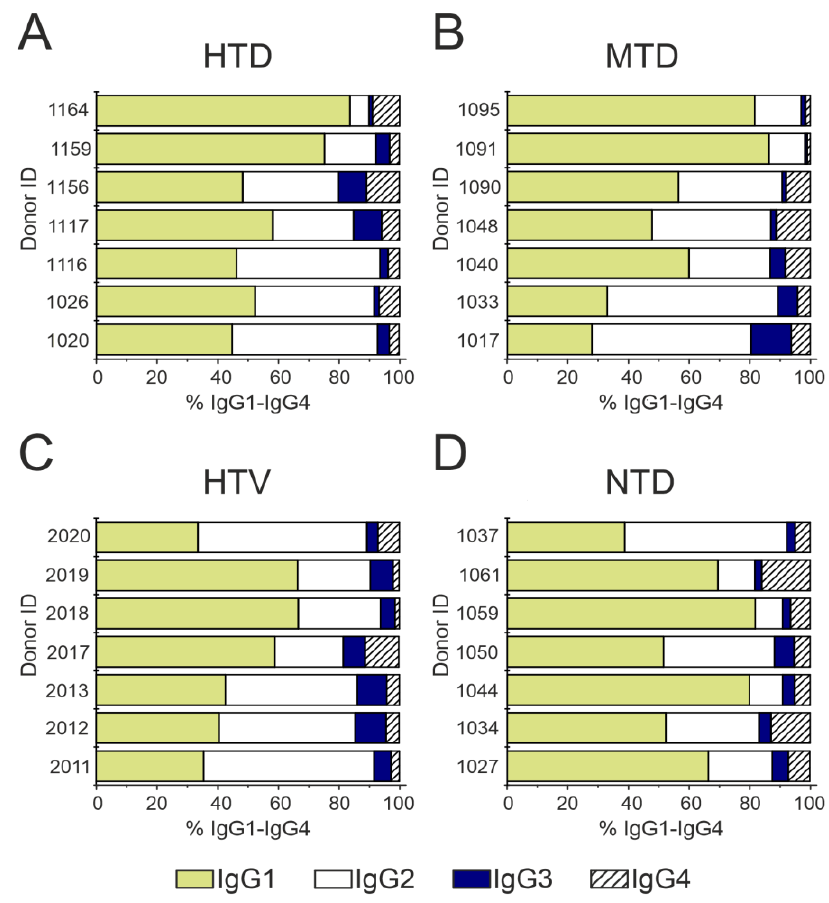
Figure 4. ELISA analysis of IgG1–IgG4 subclasses in the blood plasma of HTD ( A ), MTD ( B ), HTD patients ( C ), and NTD donors ( D ). The measurement error did not exceed 5%.